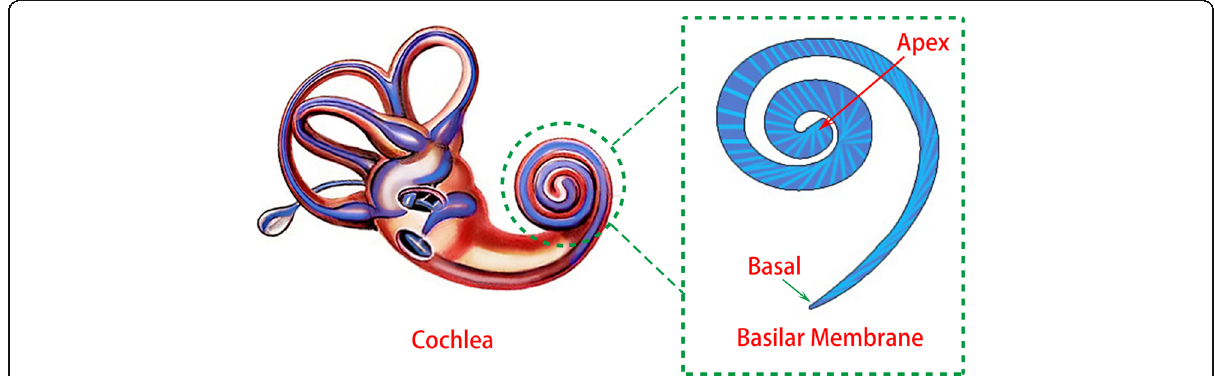
Fig. 1 Conceptual schematics of the cochlear and the basilar membrane. The basilar membrane is a spiral thin film, the width of which was reduced gradually from the apex to the